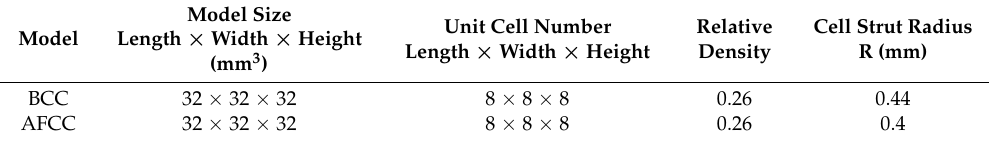
Table 3. Model parameters. AFCC: all face-centered cubic, BCC: body-centered cubic.